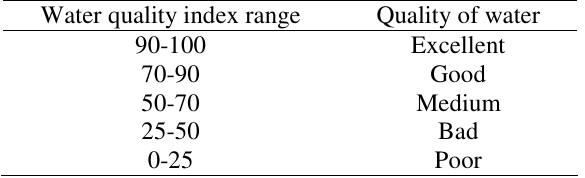
Table 2. Classification criteria standards based on NSF- WQI